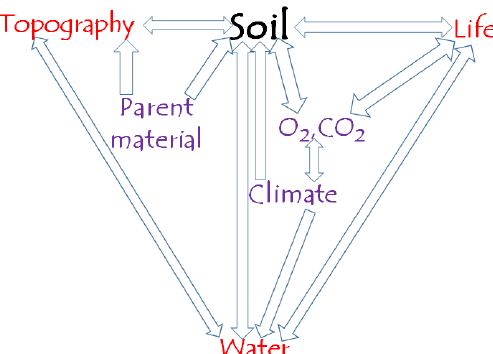
Figure 1. Inter-relationships between soil forming factors, ulti- mately controlled by parent material and climate, mediated by wa- ter, life and topography over a range of time and space